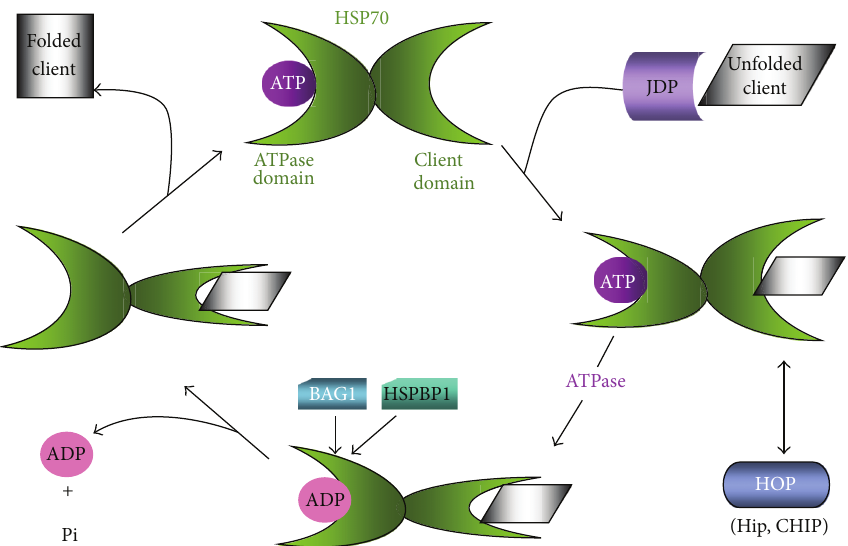
Figure 1: Reaction cycle for Hsp70 family polypeptides. Hsp70 proteins are portrayed as consisting of two major functional domains, including an N-terminal ATPase domain and a C-terminal client protein binding domain. When ATP occupies the ATPase domain, the C-terminal client protein-binding domain has weak affinity for clients. In the first step in chaperoning, the client protein (here depicted as unfolded) associated with a J domain protein (JDP) is able to bind Hsp70. This interaction causes allosteric changes in the N-terminal ATPase domain, ATP hydrolysis, and tight binding of substrate. Release of the client is then associated with nucleotide exchange loss of ADP and phosphate and replacement with ATP. In order to occur at a significant rate in cells nucleotide exchange factors such as Bag1 and HspBP1 are required. Released client is depicted as “folded.” However, the precise nature of the processes involved in achieving this state are not clear. We also show an alternative fate for Hsp70 client complexes involving the scaffold protein Hop. Hop can bind the extreme C-terminus of Hsp70 and couple it to other proteins such as Hsp90. Clients can thus be passed from Hsp70 to Hsp90 in a coordinated folding process.